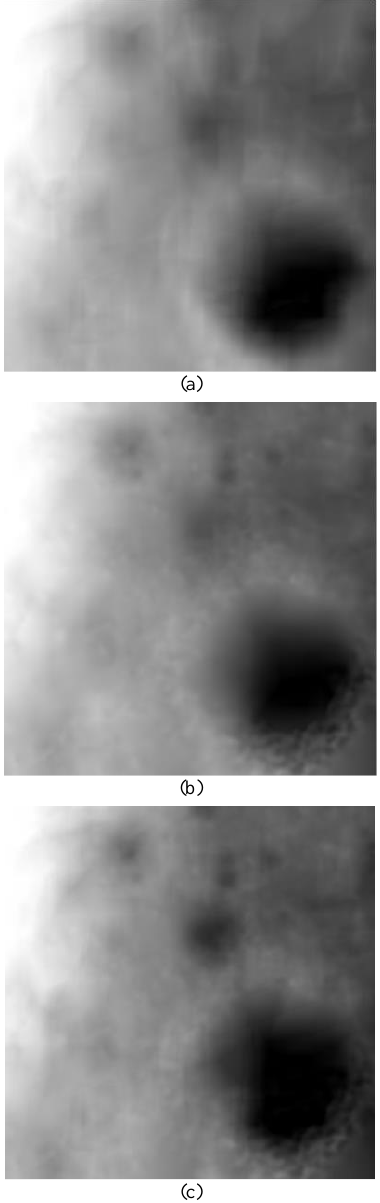
Figure 8. The reconstruction results of bilinear, kriging interpolation, and the proposed